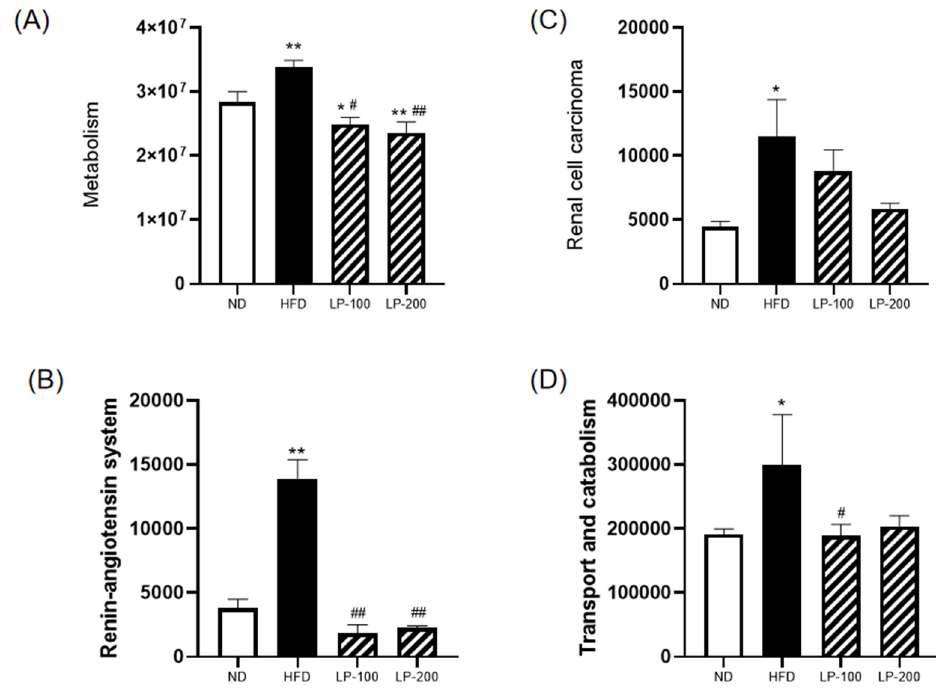
Figure 9. Functional prediction of intestinal microbiota in mice. ( A ) Metabolism, ( B ) renin–angiotensin system, ( C ) renal cell carcinoma, and ( D ) transport and catabolism. * p < 0.05, ** p < 0.01 compared with ND; # p < 0.05, ## p < 0.01 compared with HFD.